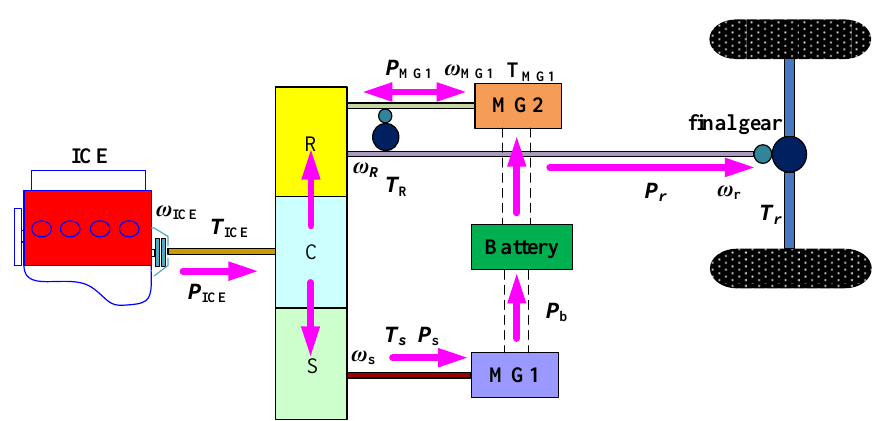
Figure 3. The diagram of the energy flows in the Prius hybrid power system.